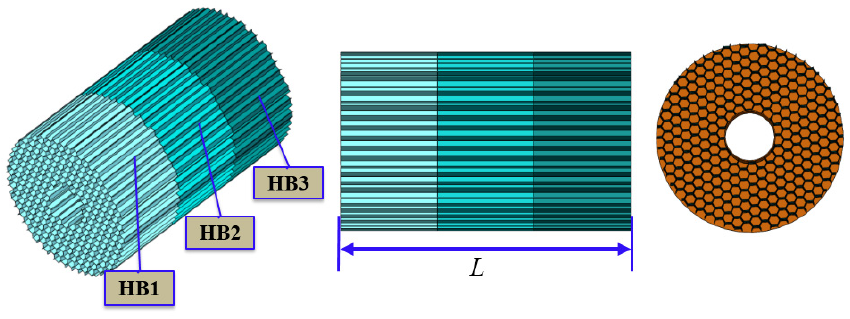
Figure 8. Buffer material collocation method.